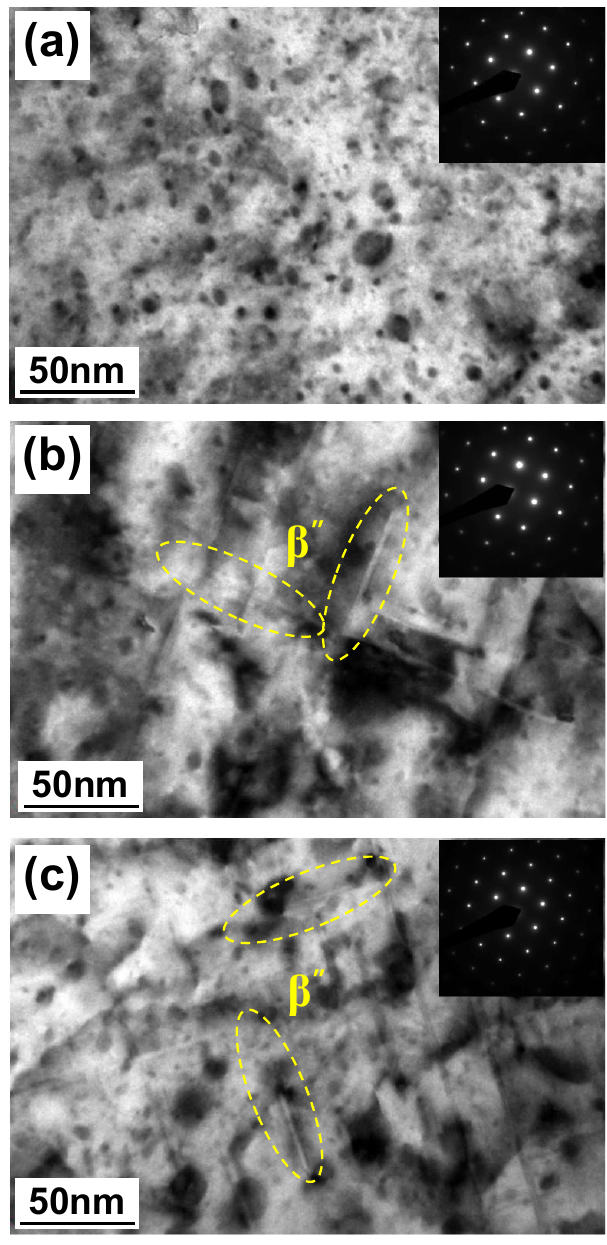
Figure 9. HR-TEM images of A356 specimens at different T5 heat treatment conditions: ( a ) as-cast, ( b ) 200 ◦ C-8 h, and ( c ) 200 ◦ C-9